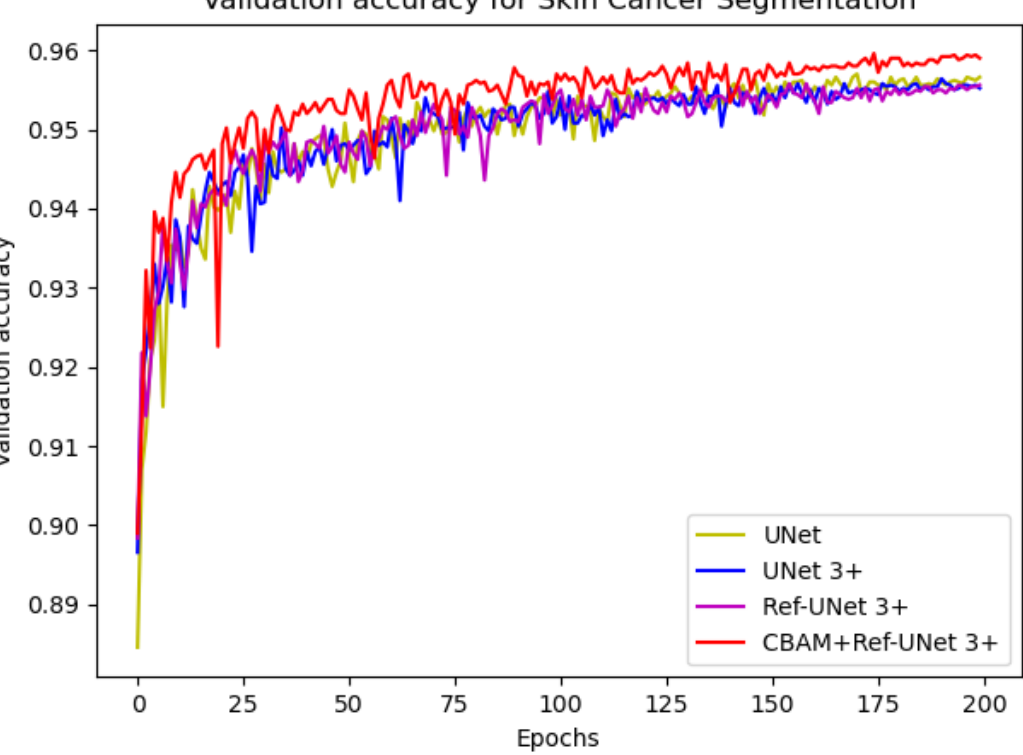
Figure 5. Comparison of validation accuracy of different models for skin cancer segmentation.